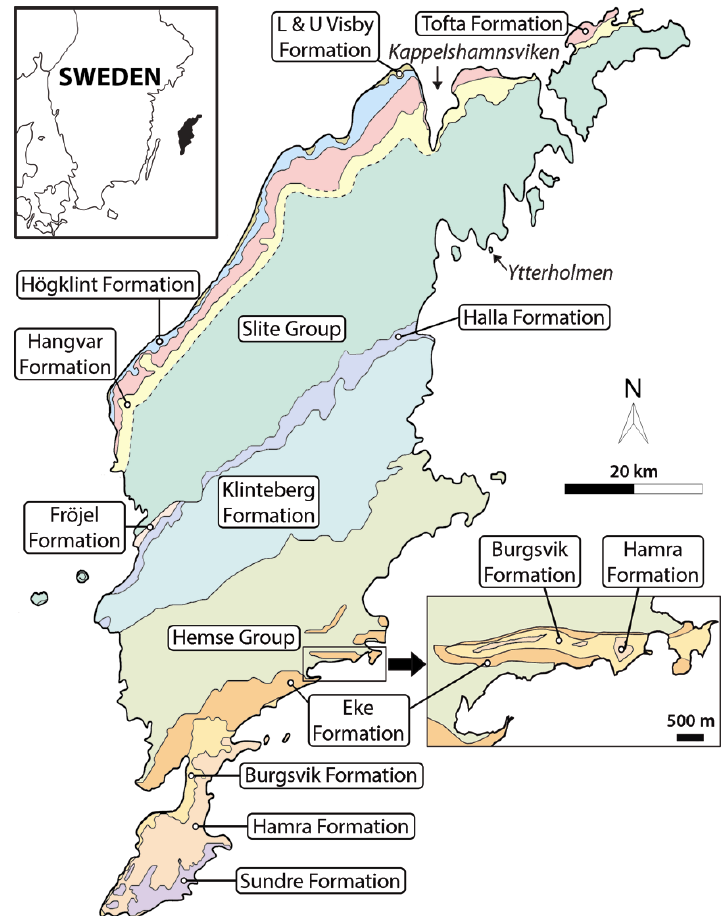
Fig. 1. Geological map of Gotland with the main stratigraphical units in colours; the colours correspond to the stratigraphical units in Fig. 2. Modified from Eriksson & Calner